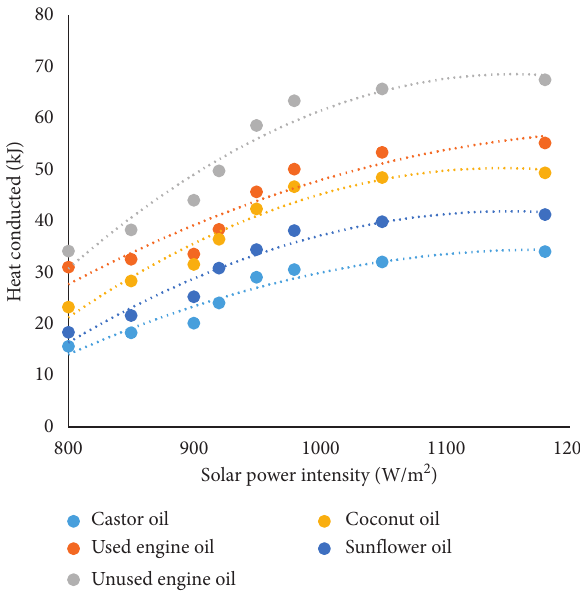
Figure 4: Average heat conducted against average solar power intensities.